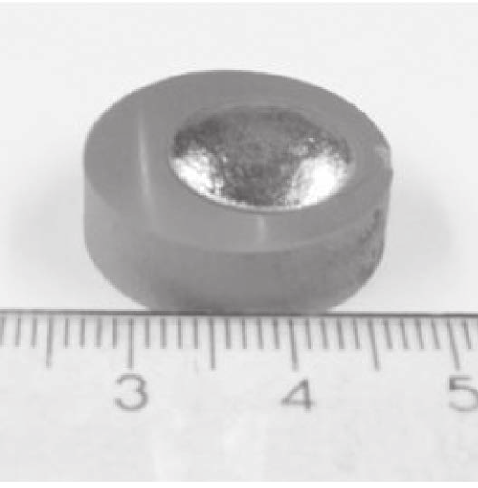
Fig. 6: Substrate and droplet after the experiment 6 Fe-TiC (3 min)